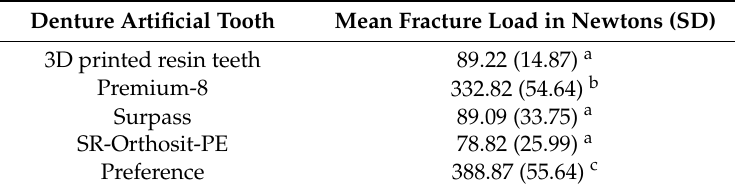
Table 2. Results of the chipping